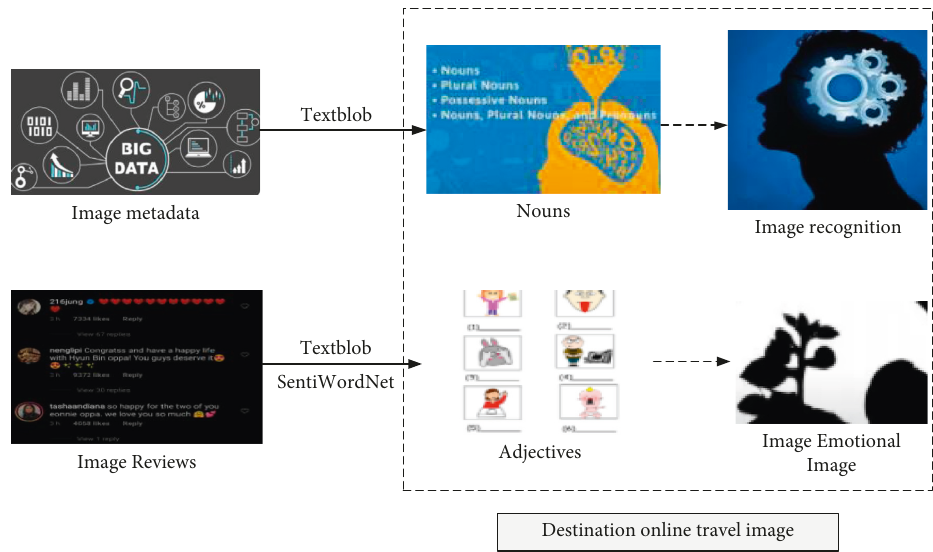
Figure 3: The illustration of the online destination image based on UGC photos’